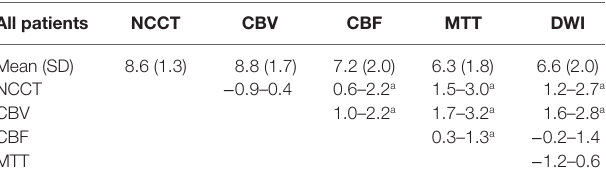
Table 2 | Comparison of the mean value of ASPECTS (95% CI for difference between means, paired t -test). all patients